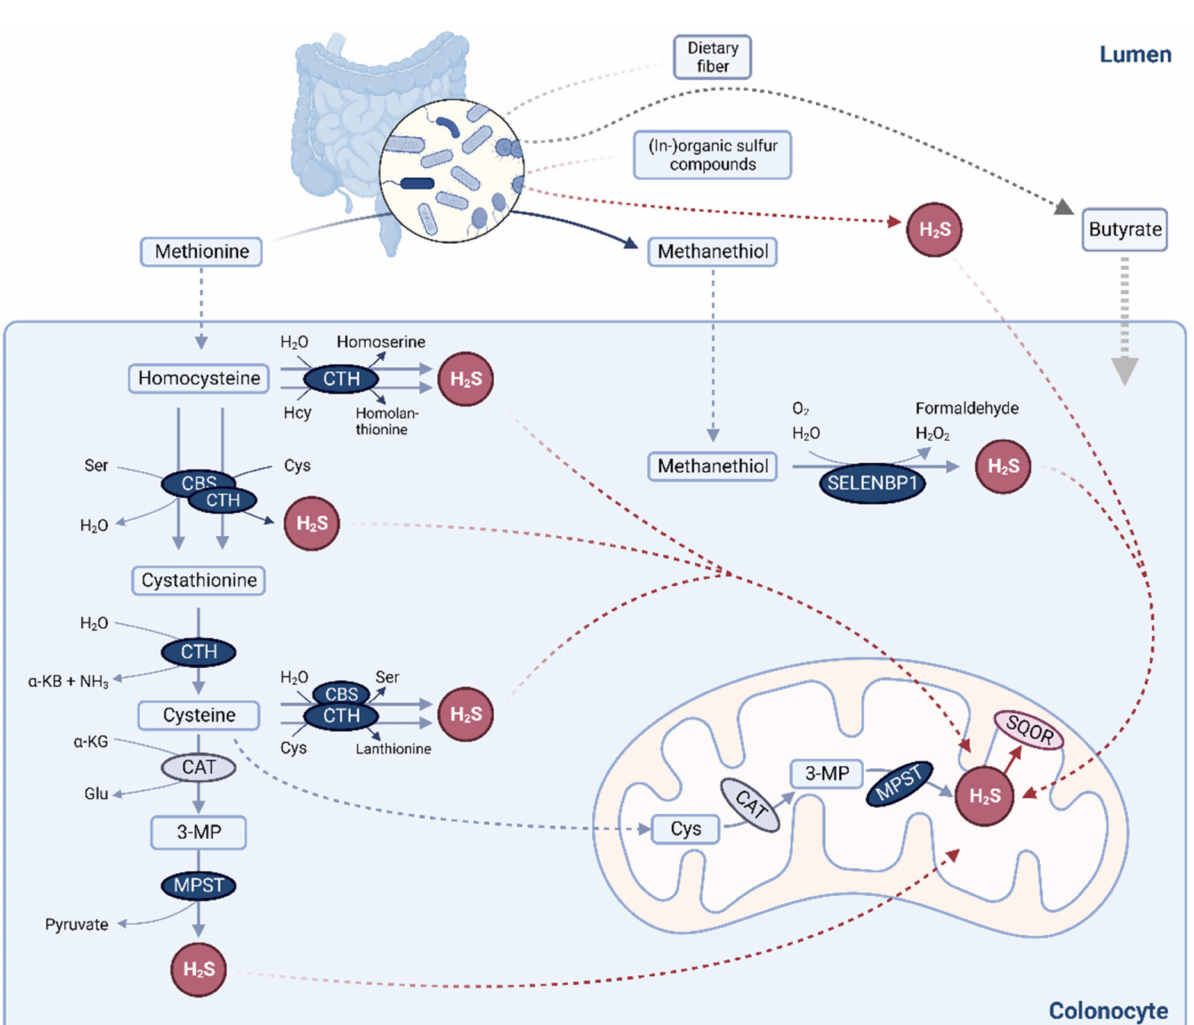
Figure 1. Overview of H 2 S biogenesis in the mammalian colon. Gut microbiota generate H 2 S by fermentation of dietary sulfur-organic compounds and by sulfate reduction (as well as butyrate by fermentation of dietary fiber). H 2 S production in colonic epithelial cells occurs through the four enzymes CBS, CTH, MPST and SELENBP1. Sulfur-containing amino acids serve as precursors for H 2 S production by CBS, CTH and MPST, while the SELENBP1 substrate methanethiol is produced from methionine by colonic microbiota. SQOR is a key enzyme in H 2 S catabolism. Scheme created with